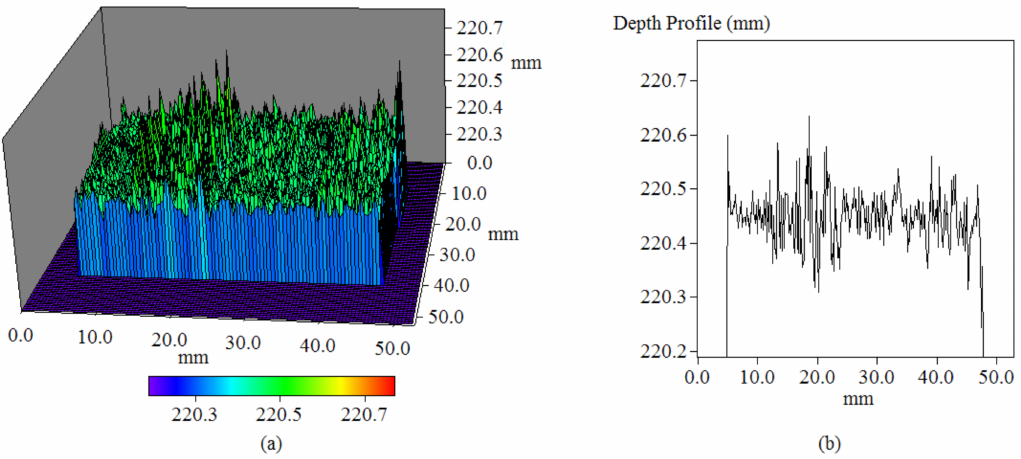
Figure 10. ( a ) The retrieved profile. ( b ) One-dimensional profile distribution along the x -axis. As a comparison, a combination of binary-coding and phase-shifting projections [16] were employed to retrieve the profile of the gauge block. Figure 11a,b shows the 1D distributions of the patterns used to perform the five-step phase-shifting technique and to identify the fringe orders, respectively. The sequential projections of the binary patterns shown in Figure 11b formed codewords. The fringe orders were then discerned using the codewords. The total number of sinusoidal fringes was 64. Hence, the number of binary patterns was six (i.e., 2 6 = 64). Using Equation (14), the absolute phases could be obtained. Again, as described in Equations (15)–(17), the profile was retrieved using the absolute phase. The coefficients in Equations (15)–(17) were identified using the calibration scheme described in [5,6]. Figure 12a shows the retrieved profile. Its 1D profile along the x -axis is shown in Figure 12b. The gray level of the sinusoidal fringes was ranging from 25 to 225, which was the same as the “0”-encoded fringe described in Equation (2). Consequently, the systematic accuracy was similar to that at the area of the “0”-encoded fringes, approximately 100 µ